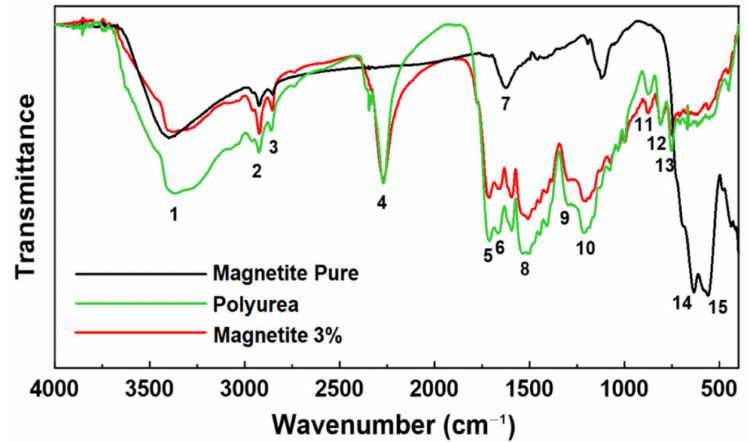
Figure 5. FTIR spectra of polyurea, pure magnetite, and 3% magnetite-modified composite. The main characteristic bands were identified by numbers from 1 to 15 attributed to the band assignments in Table